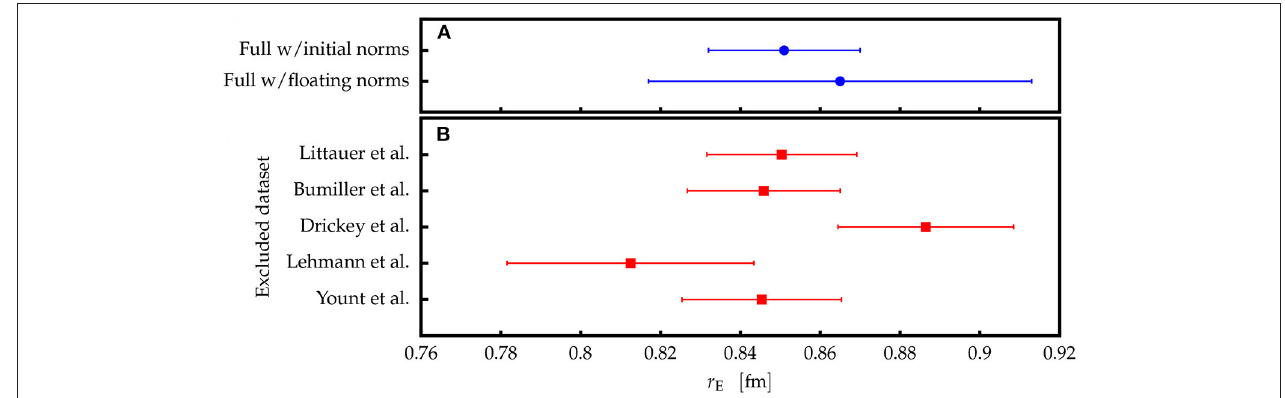
FIGURE 3 | The extracted values of the proton charge radius. (A) The difference between the value obtained with the fixed and floating normalization parameters. Addition of five free parameters significantly increases the uncertainty of the radius. (B) Calculated radii when performing the analysis with only four out of five data sets, demonstrating a tension between the data sets of Drickey et al. [25] and Lehmann et al.